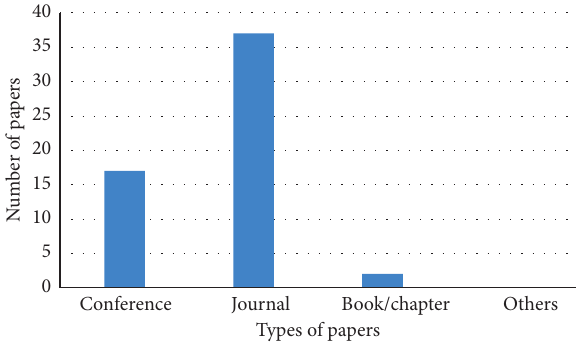
Figure 11: Overall papers with types and total number of articles.